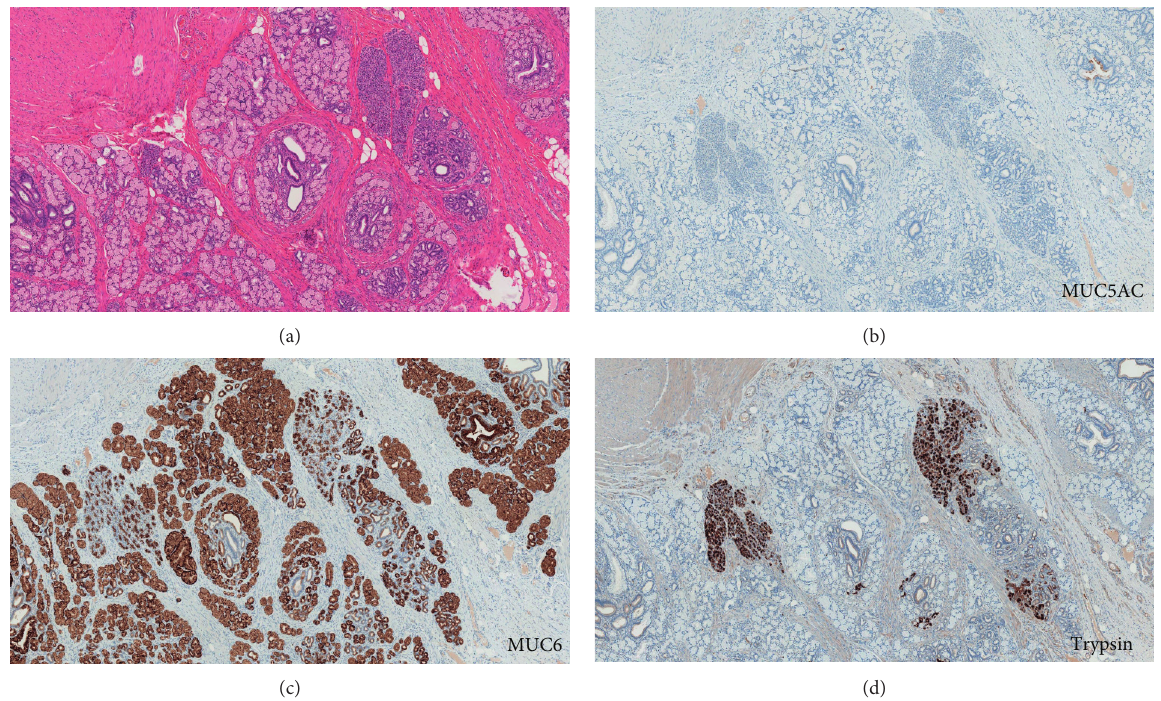
Figure 5: Histological findings. Organoid structure composed of large ducts surrounded by radially extending acini and small ducts resembling Brunner or pyloric glands (hematoxylin and eosin staining: HE (a)). Immunohistochemical study shows that MUC5AC is negative (b), whereas MUC6 is positive (c). Acinar cells are positive for trypsin